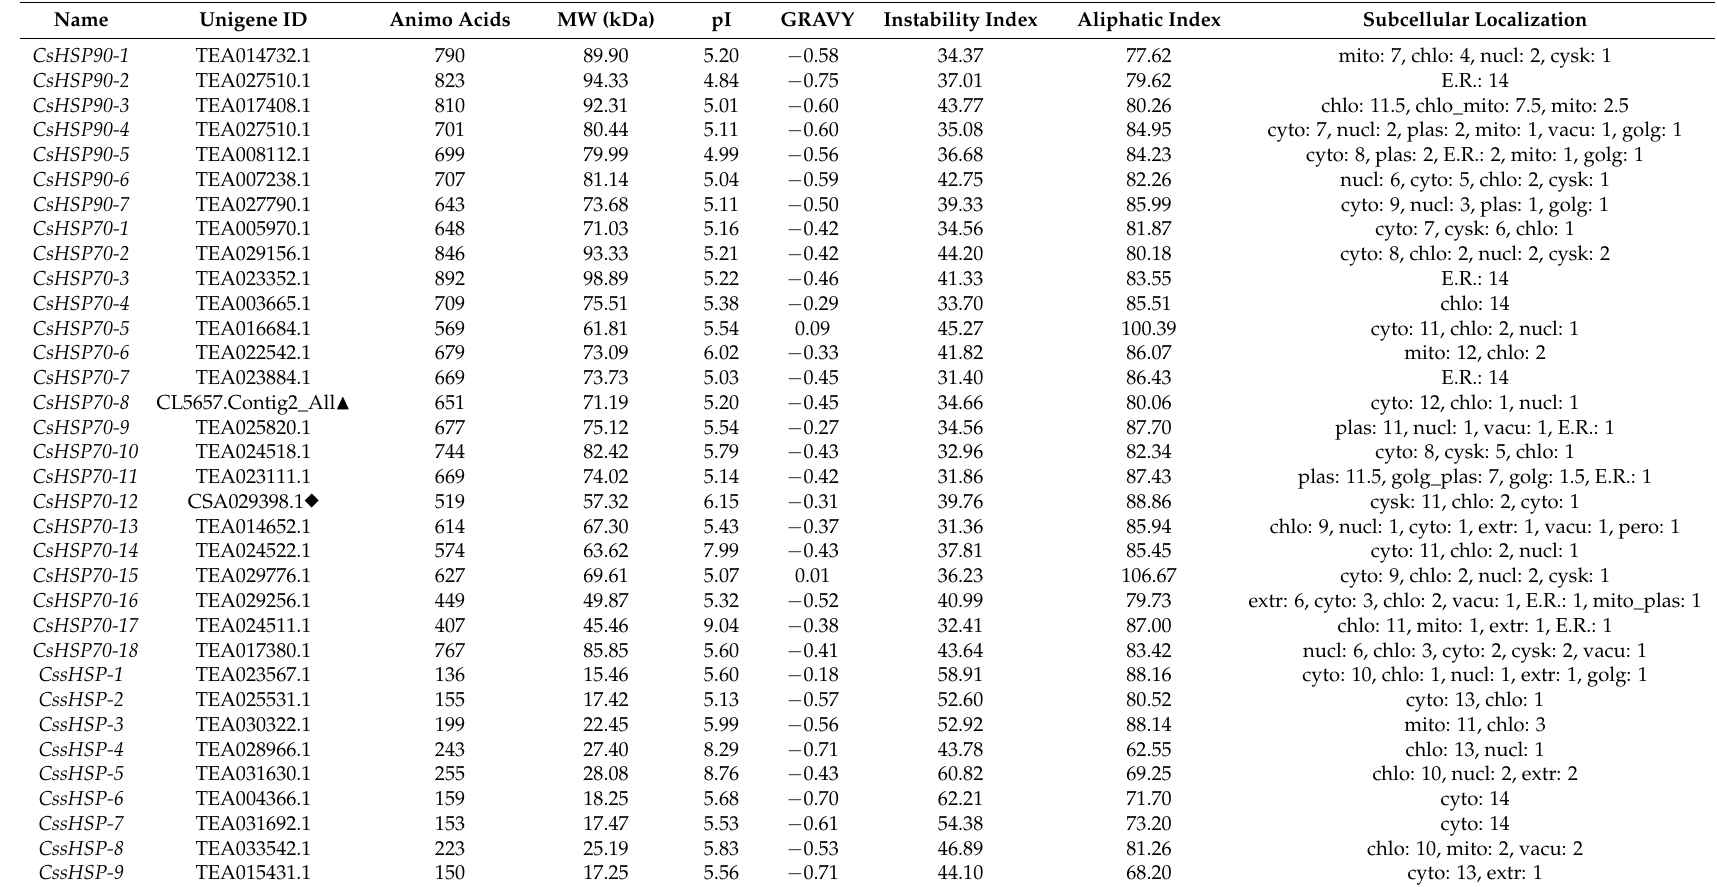
Table 1. Summary information of physiological and biochemical properties of the CsHSP proteins.